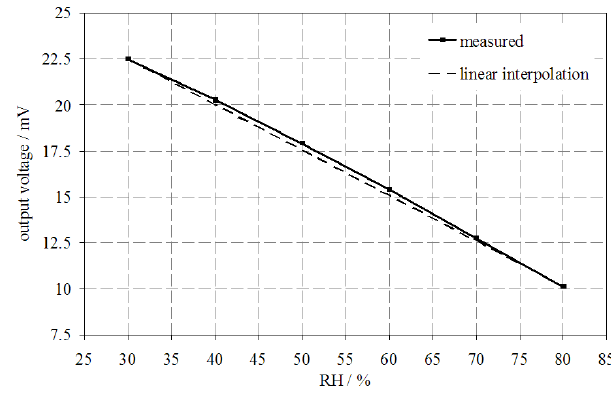
Figure 8. Comparison of the output voltage measured with the lin- ear interpolation of the endpoints at 30 and 80%RH. The maximum error for four sensors was 3.1% FS, so linear interpolation is not sufficient if an accuracy of better than 3% FS is required.